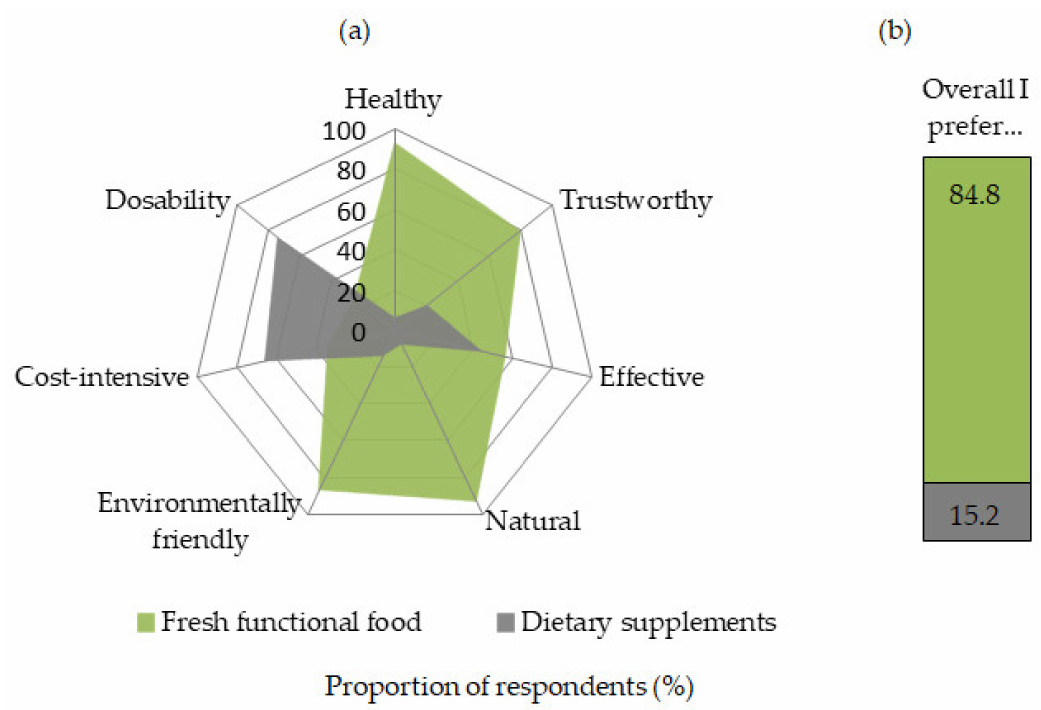
Figure 7. Consumer evaluation of iodine-containing fruit and vegetables and dietary supplements based on various decision factors ( a ) and a comparison of preferences as a whole ( b ). n =